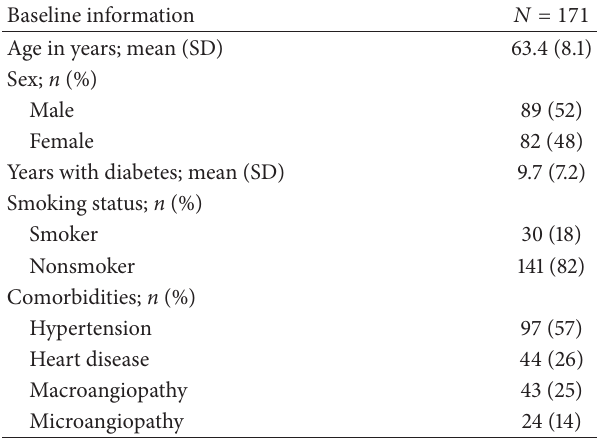
Table 1: Baseline characteristics of participating